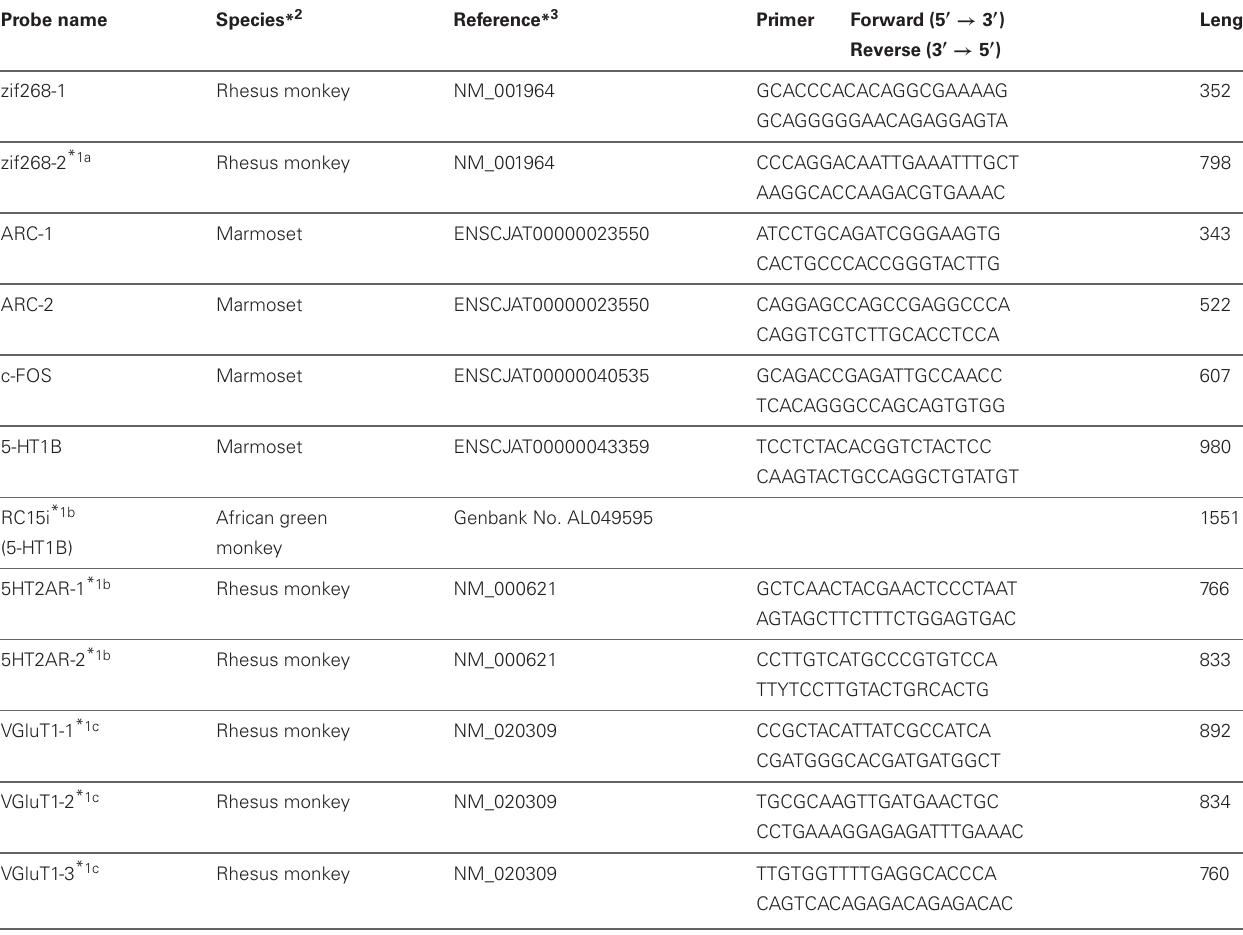
Table 2 | ISH probes used in current